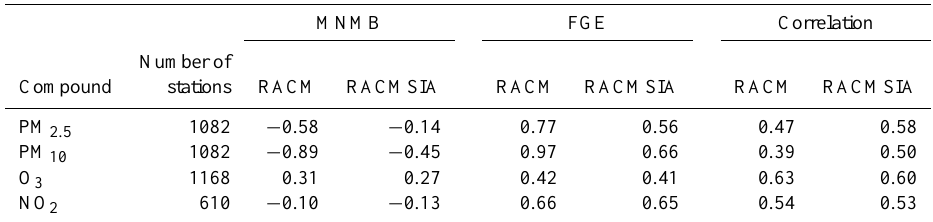
Table 14. Air quality regulated pollutant statistics of simulations against hourly AIRBASE observations. Comparison between a simulation with SIA (RACMSIA) and without SIA formation (RACM).